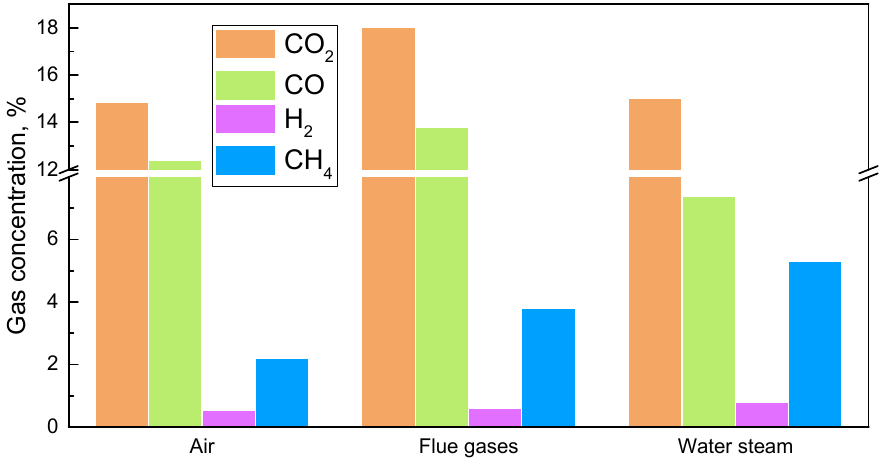
Figure 5. Gas component concentrations in the pyrolysis of biomass (sawdust 25%, straw 50%, leaves 25%) in different atmospheres at a pyrolysis temperature of 500 °C.